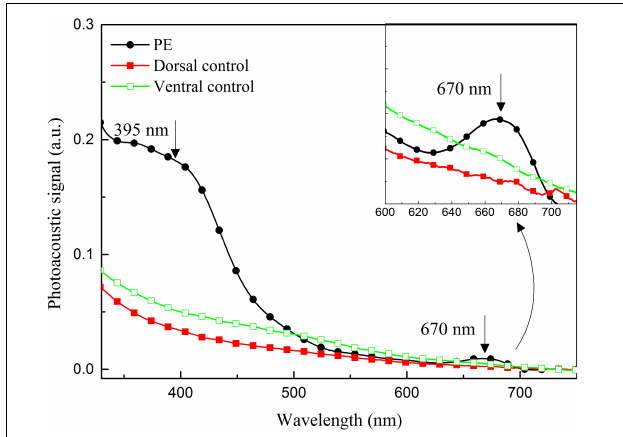
FIGURE 4 | Photoacoustic spectra of: propolis extract (PE); dorsal surface of nail without PE application (Dorsal control); ventral surface of nail without PE application (Ventral control). Arrows indicate bands of optical absorption of PE. In right corner, the band centered at 670